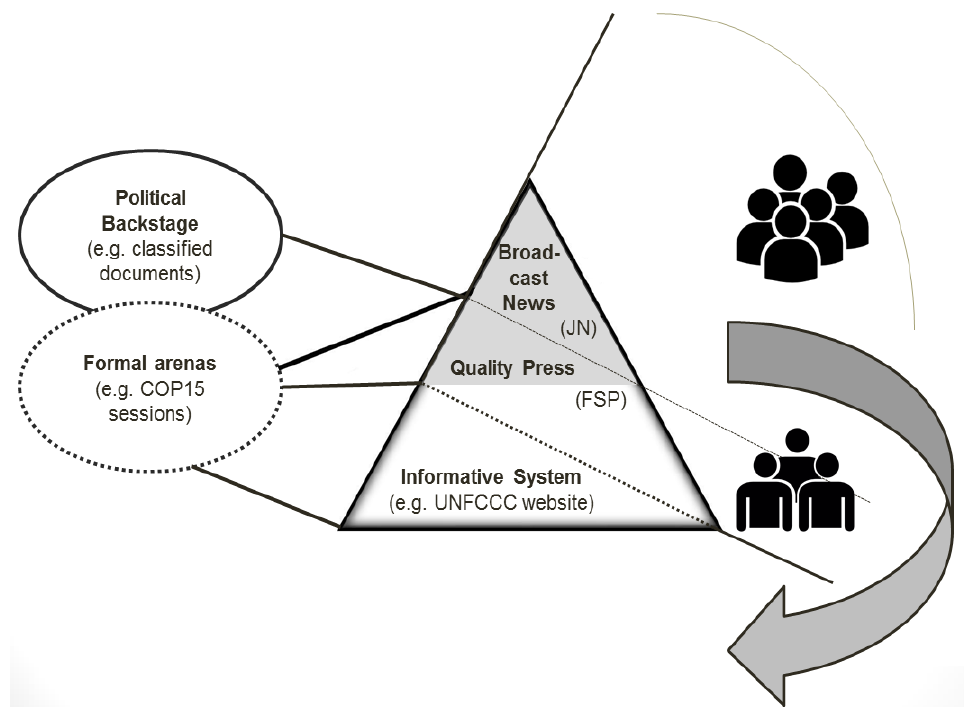
Figure 2. The News Media System as Prism of The Public